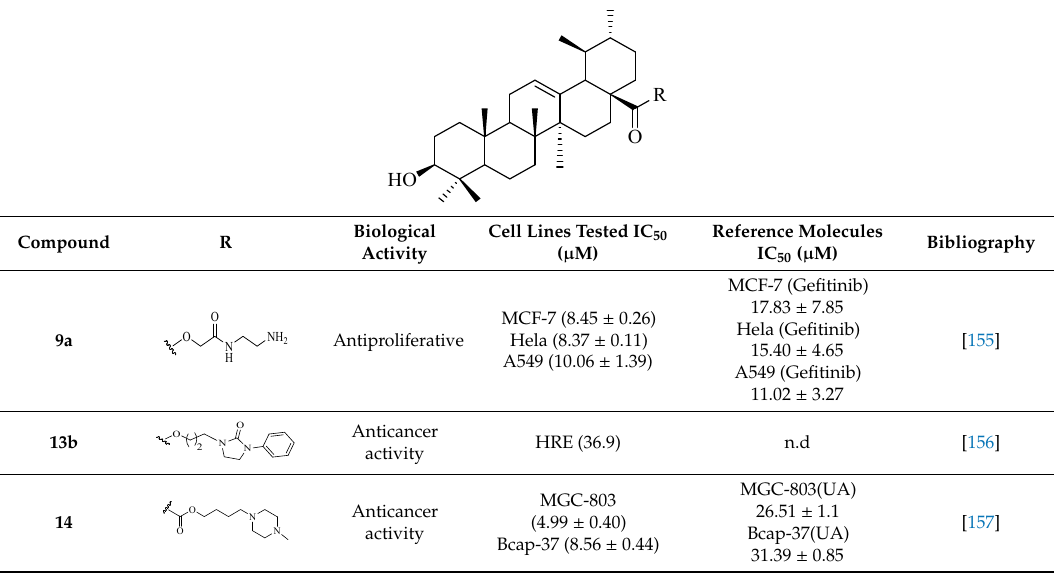
Compo Compo und und